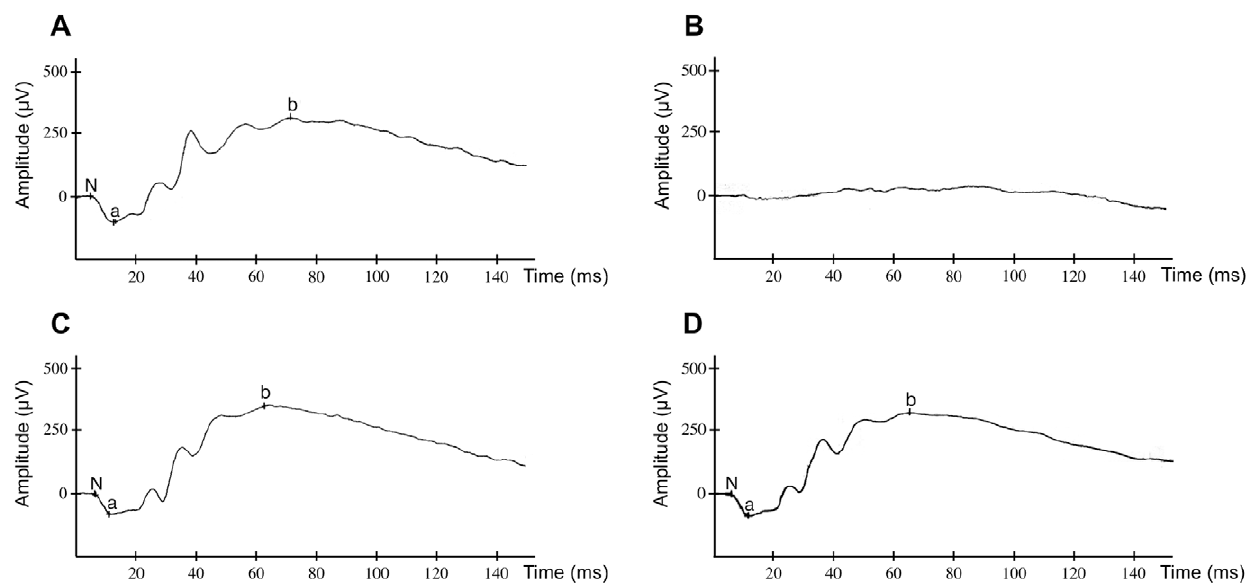
Figure 3. Scotopic electroretinography (ERG) recordings. Electroretinographic responses in ( A ) an unaffected LEW- ci2 rat (MedSchool), ( B ) an affected LEW- ci2 rat (VetSchool) with extinct curve (no response), ( C/D ) corresponding, unaffected controls (MedSchool/VetSchool), exemplary for the whole groups. Recorded by a stimulus with a light intensity of 3 cd s/m 2 . N=basic value, a=a-wave, b=b-wave, Time=implicit time.